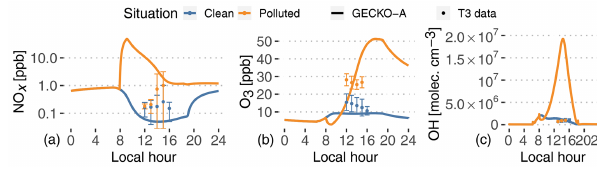
Figure 6. Experimental (dots, T3 site) and modeled (lines, second day) time evolution of NO x ( a , note log scale), ozone mixing ratios (b) and OH radical concentrations (c) . The vertical range of the ex- perimental data denotes the standard deviation of measured concen- trations at T3 during events identified as clean (blue) and polluted (orange).